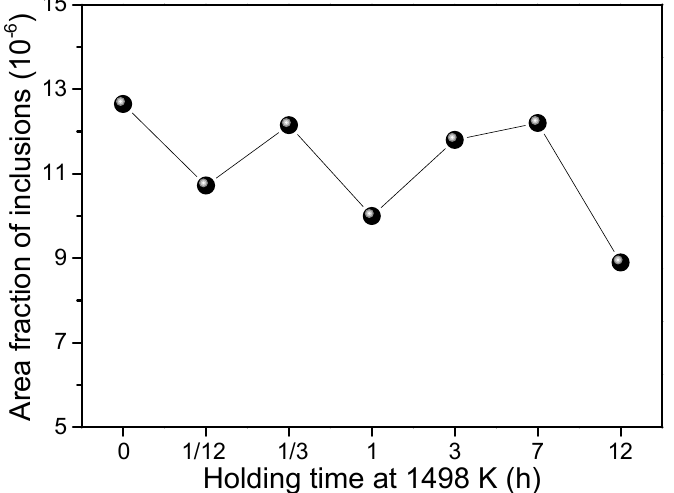
Figure 11. Variation in the size distribution of inclusions in the steel during heat treatment at 1498 K.